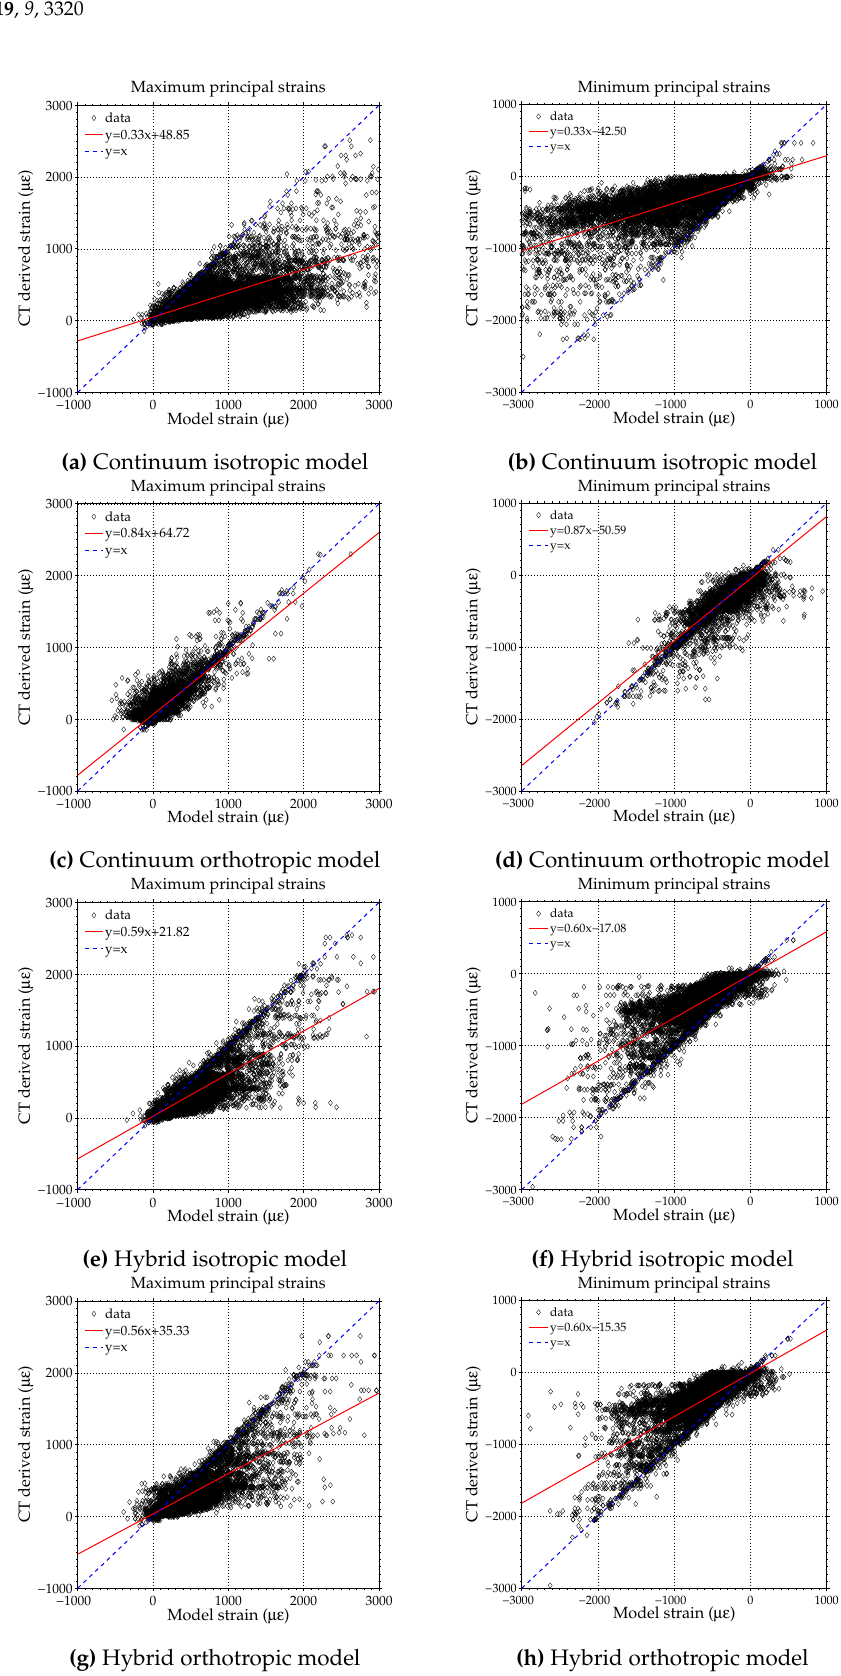
Figure 7. Comparison between the maximum ( a , c , e , g ) and minimum ( b , d , f , h ) principal strains across the surface of the continuum and hybrid models ( x -axis) and CT derived model ( y -axis). Lines of best fit are shown in red for each case, with the y = x line shown in dashed